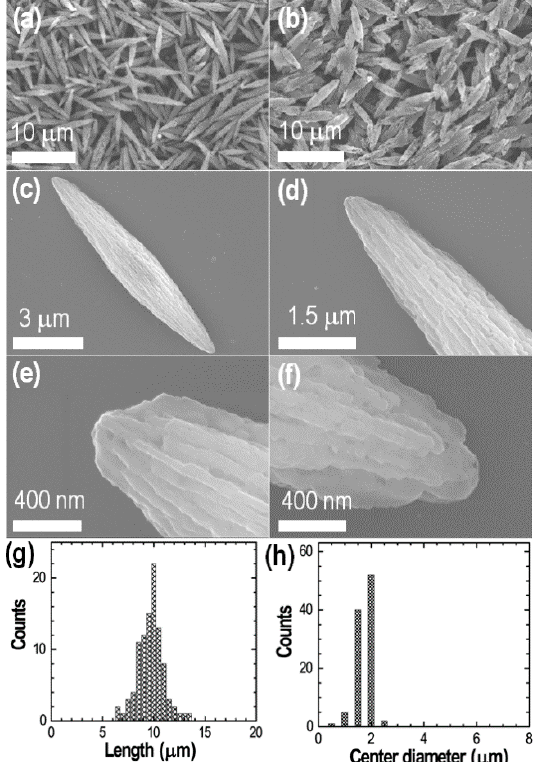
Figure 1. SEM images of fullerene C 60 crystals self-assembled at a liquid-liquid interface of IPA and C 60 solution in dodecylbenzene at 25 ◦ C: ( a , b ) Low magnification images showing over all surface morphology; ( c , d ) SEM images of one crystal showing bitter-melon shape; ( e , f ) High resolution SEM images; ( g , h ) Histograms of length and diameter distributions.